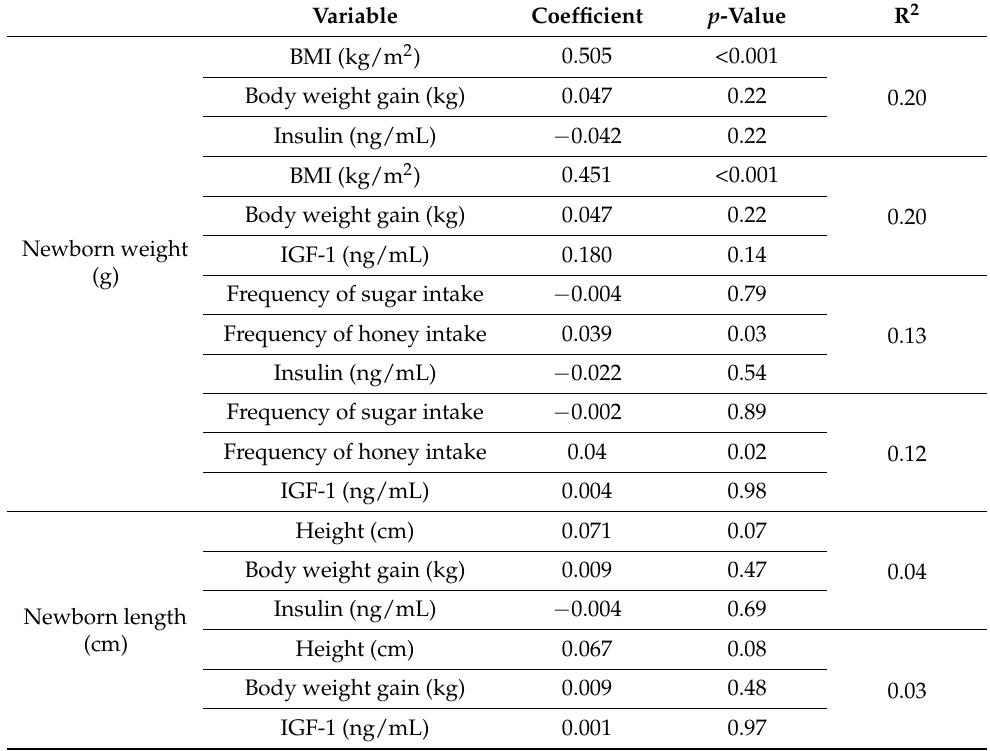
Table 6. Multiple regression analysis considering the weight, length, and Ponderal index of newborn ( n =